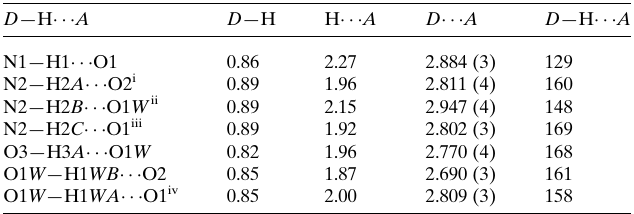
Table 1 Hydrogen-bond geometry (A˚ , (cid:4) ).